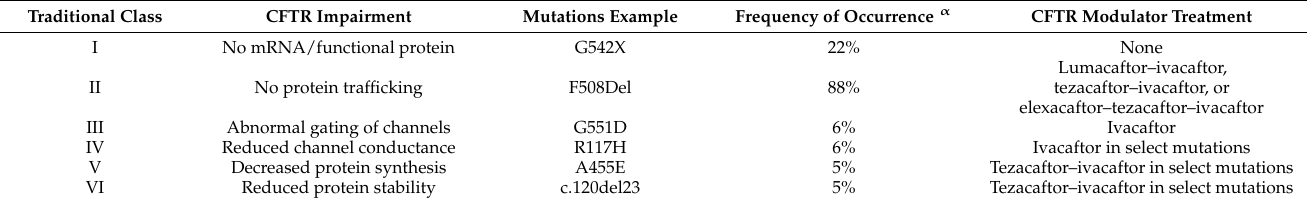
Table 1. Cystic fibrosis transmembrane receptor (CFTR) mutation classes, functional impairment, frequency, and CFTR modulator therapies. α Occurrence of at least one mutation in that class based on United States registry data